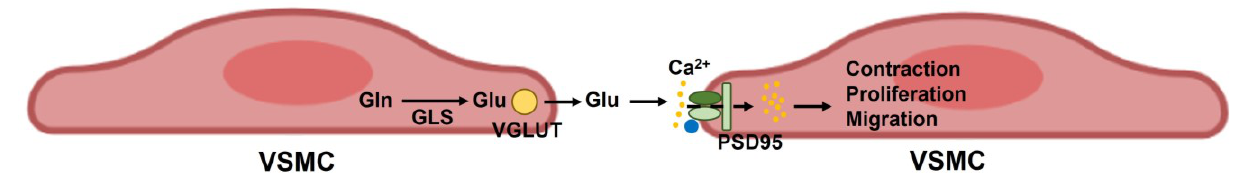
Figure 4. Model of NMDAR-mediated quasi-synaptic communication between adjacent VSMCs in pulmonary circulation. A recent investigation by Dumas and coworkers [86] proposed a quasi-synaptic mode of glutamatergic communication via NMDARs between adjacent VSMCs in human pulmonary circulation. According to this mode, glutamate (Glu) is formed directly from glutamine (Gln) by glutaminase (GLS1 and/or GLS1) and is thereafter released in the extracellular space through the vesicular glutamate transporter (VGLUT). Herein, Glu binds to juxtaposed NMDARs that are located on adjacent VSMCs and stimulates the influx of extracellular Ca 2+ , which in turn promotes VSMC contraction, proliferation, and migration. It has been suggested that the PDZ scaffolding protein, PSD95, contributes to recruit, anchor and cluster NMDARs on the plasma membrane.